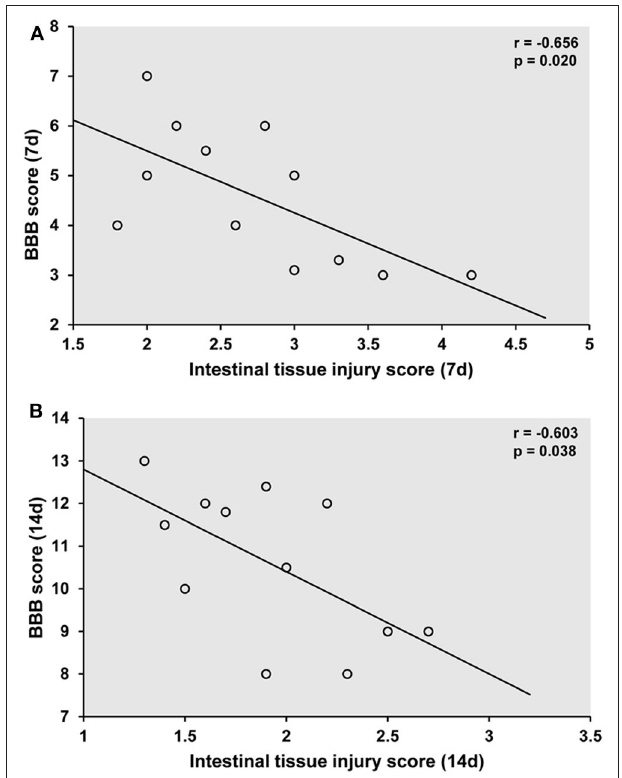
FIGURE 8 | Association of locomotor recovery with intestinal mucosal tissue injury on postoperative days 7 (A) and 14 (B) in the SCI + HBO group. Pearson analysis showing the significant negative correlation between the recovery of locomotor function after HBO treatment and the degree of intestinal mucosal tissue injury in the SCI + HBO group ( P < 0.05). SCI, spinal cord injury; HBO, hyperbaric